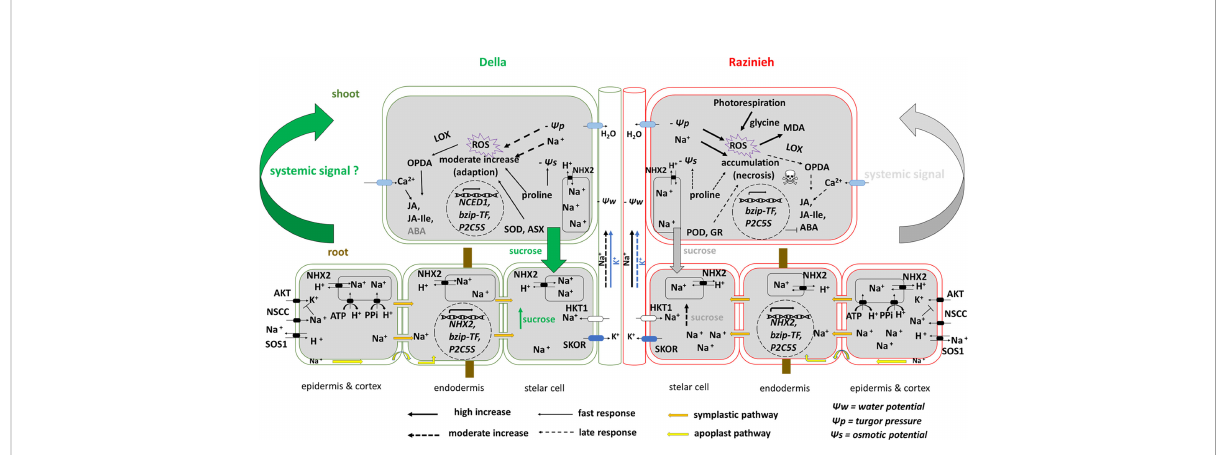
FIGURE 10 Visual model representing two contrasting sorghum genotypes to salt stress. The salt adaption in Della genotype is linked with better sequestration of Na + in the vacuoles of root cortex cells and restricted translocation of Na + from root to shoot. In addition to rapid translocation of sucrose to the roots and depending on ef fi cient redox homeostasis and proline accumulation in leaves. Meanwhile glycine accumulation in Razinieh leaves and H 2 O 2 abundance were considered as markers of high photorespiration rate coupled with the observed phenotype of leaf necrosis related to stress susceptibility which could be linked to the accumulation of MDA as a result of higher lipid peroxidation due to ROS